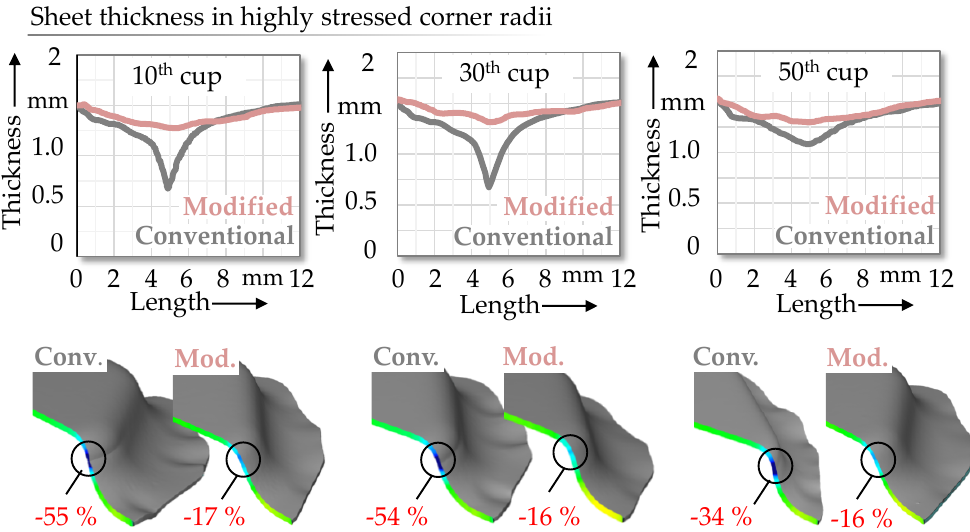
Figure 19. Resulting sheet thickness thinning of the hot stamped rectangular cups.